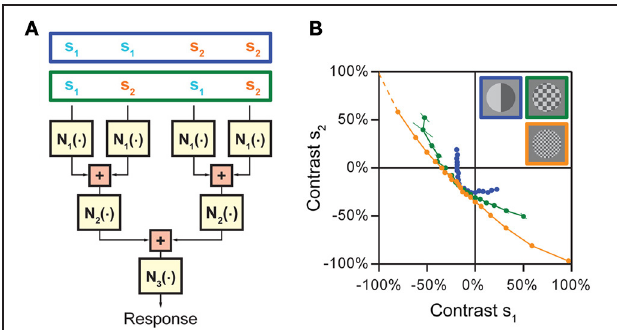
FIGURE 6 | Approach for disentangling non-linearities at multiple stages of stimulus integration in hierarchical models. (A) Cascade model with three consecutive non-linear stages, N 1 , N 2 , and N 3 , separated by two integration stages. The model assumes that first nearby stimulus components are integrated, whose results are then combined in a subsequent stage. Different stimulation schemes that can be used to separate the effects of the non-linearities are shown on top. When nearby input channels are stimulated with the same stimulus component s 1 or s 2 , respectively (stimulus pattern in blue box), the iso-response curve is affected by the combination of N 1 and N 2 . When the two stimulus components s 1 and s 2 are placed so that they are combined already by the first integration stage (stimulus pattern in green box), only non-linearity N 1 is relevant for the shape of the iso-response curve. (B) Application of the strategy to separate different integration stages of spatial integration by retinal ganglion cells. When nearby spatial locations receive the same contrast (blue data points), the iso-rate curve shows the standard threshold-quadratic non-linearity as in Figure 4C . When the two contrast components s 1 and s 2 are interleaved so that presynaptic bipolar cells typically already start integrating the two components, but individual photoreceptors only receive either one of the components (green and orange data points, corresponding to squares in the stimulus layout with 150 and 60 μ m side length, respectively), the iso-rate curves approach straight lines, showing that the integration stage from photoreceptors to bipolar cells can be approximated as linear integration. Panel (B) reprinted from Bölinger and Gollisch (2012), Copyright (2012), with permission from